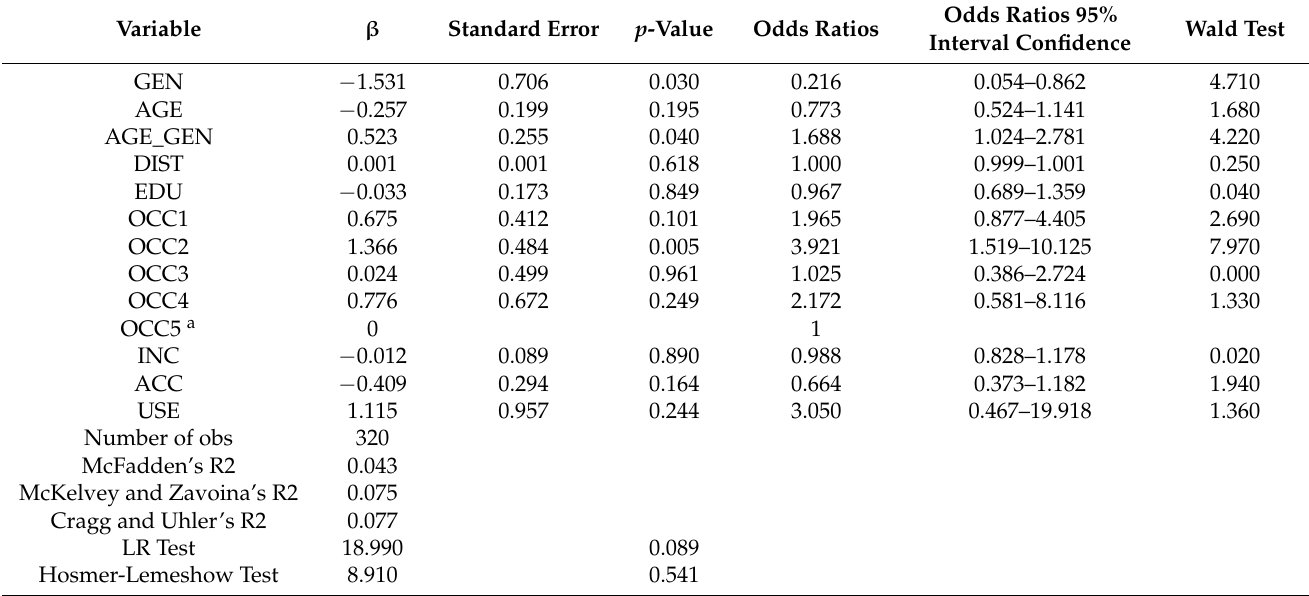
Table 1. The logistic regression output (dependent variable: